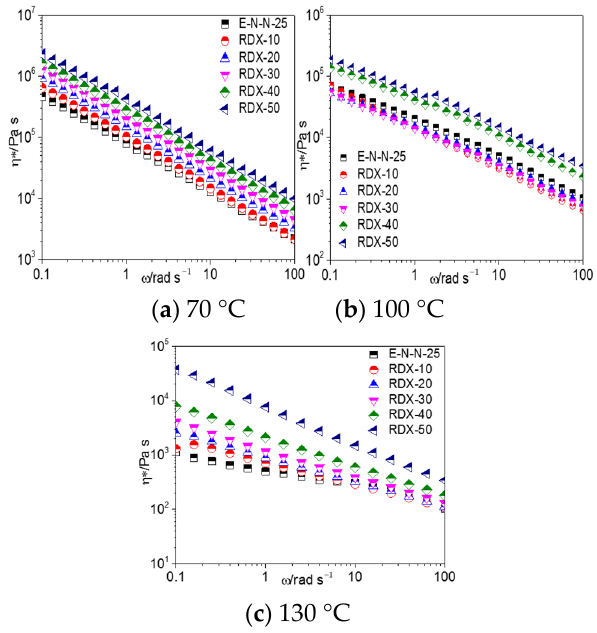
Figure 10. η *– ω curves of model propellants at ( a ) 70 °C , ( b ) 100 °C, and ( c ) 130 °C .